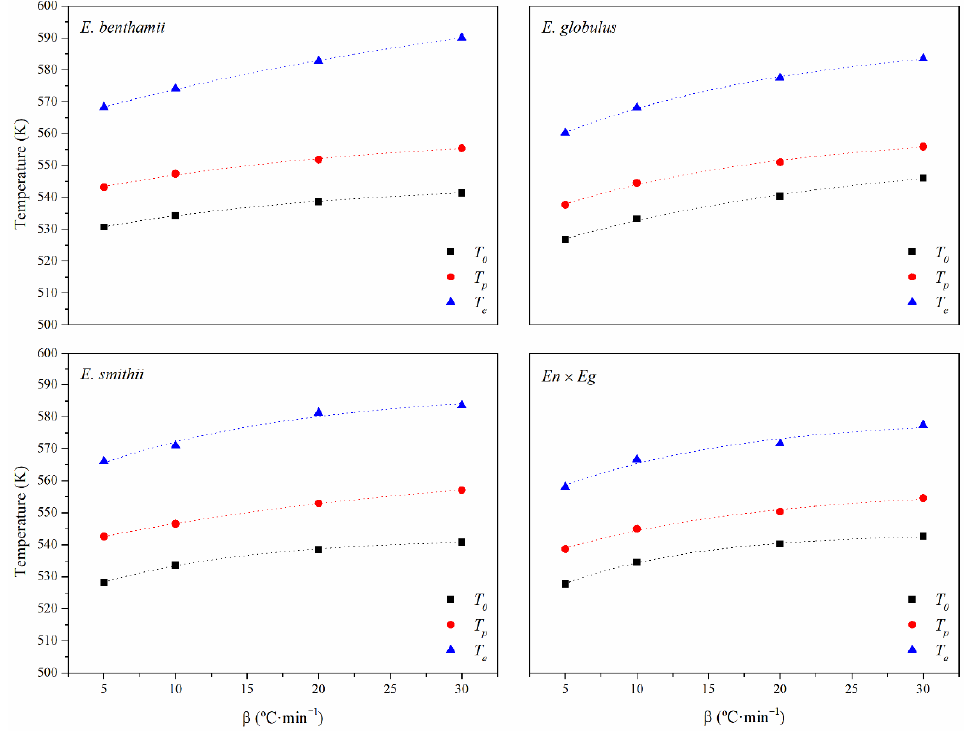
Figure 6. Evolution of the onset ( T o ), peak ( T p ) and endset ( T e ) temperatures as a function of the heating rate ( β ) of the CNCs obtained from the different eucalyptus species. Standard deviations below 2 K were omitted for the sake of clarity. Table 6. Values of ZDT along with the fitting parameters and regression coefficient for the thermal decomposition of CNC ( T o , T p , T e , ∆ m cel ) when β → 0. Standard error was omitted for the sake of clarity.